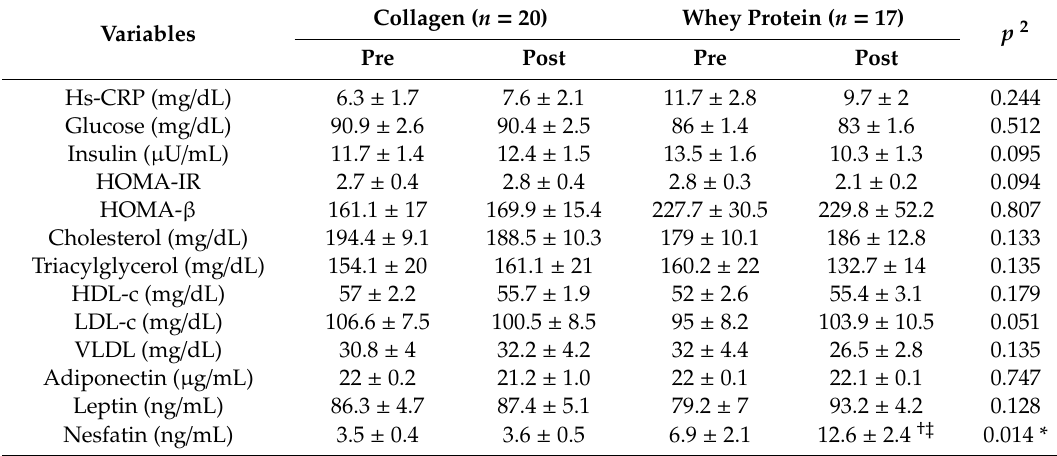
Table 4. Biochemical parameters 1 .